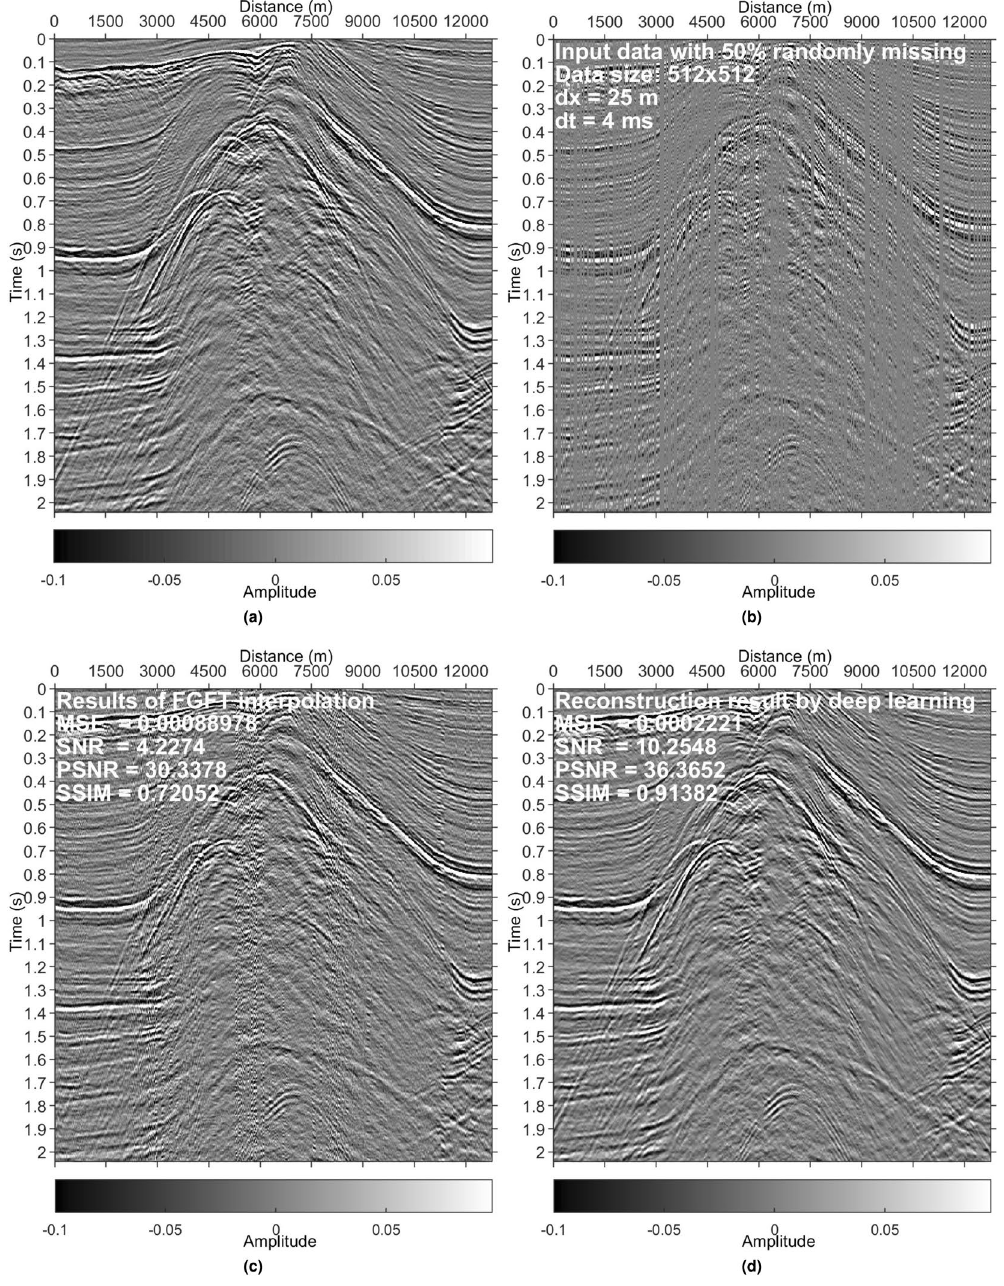
Figure 12. Results on a data set from the North Sea. ( a ) Reference data. ( b ) Irregularly sampled data with 50% missing. ( c ) Interpolated data using the FGFT interpolation method 23 . ( d ) DL reconstruction